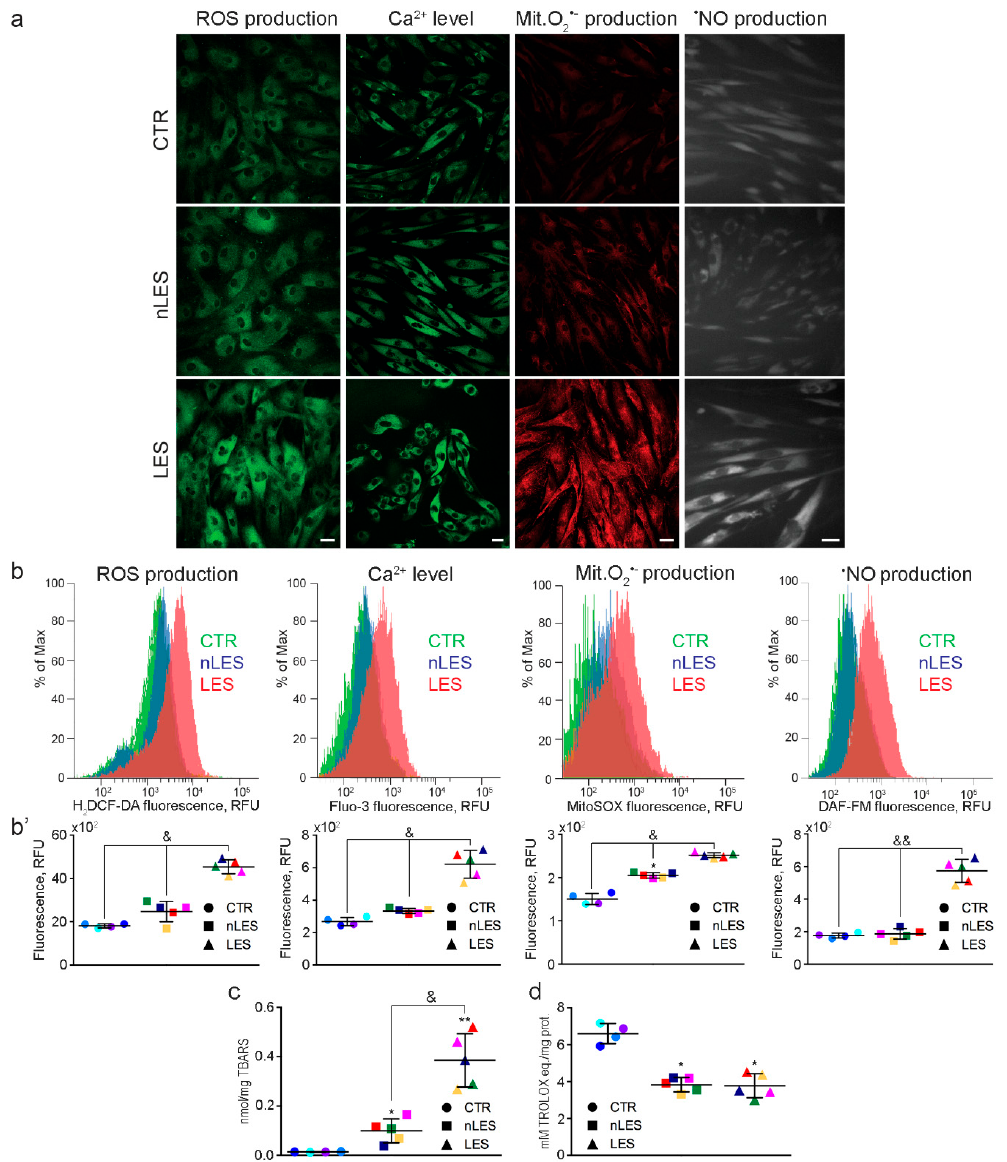
Figure 3. Assessment of redox markers in human psoriatic fibroblasts. For the assessment of the intracellular levels of ROS, Ca 2 + , mitochondrial superoxide anion production and • NO, CTR, nLES and LES fibroblasts were stained with the fluorescent markers H 2 DCFDA, Fluo-3, MitoSOX, and DAF-FM, respectively. ( a ) Confocal microscope analysis, and ( b , b’ ) FACS analysis revealed signs of oxidative / nitrosative stress in LES fibroblasts. ( c ) Thiobarbituric acid reactive substance (TBARS) assay revealed increased lipid peroxidation in LES with respect to nLES and CTR fibroblasts. ( d ) Decreased total antioxidant capacity measured by oxygen radical antioxidant capacity (ORAC) assay and expressed in Trolox equivalents was evident in psoriatic versus CTR fibroblasts. In dot plot graphs, each patient / control is identified by a di ff erent color (see Table 3). Values are presented as means ± SD. Each experiment was performed in triplicate. & p < 0.05, && p < 0.01. * p < 0.05 vs. CTR, ** p < 0.01 vs. CTR. Scale bar = 20 µm.